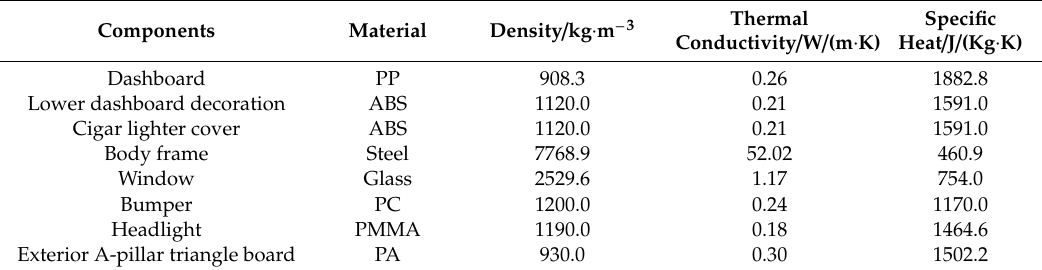
Figure 5. Discrete model of sedan with three compartments. Table 4. Physical property parameters of some key parts.